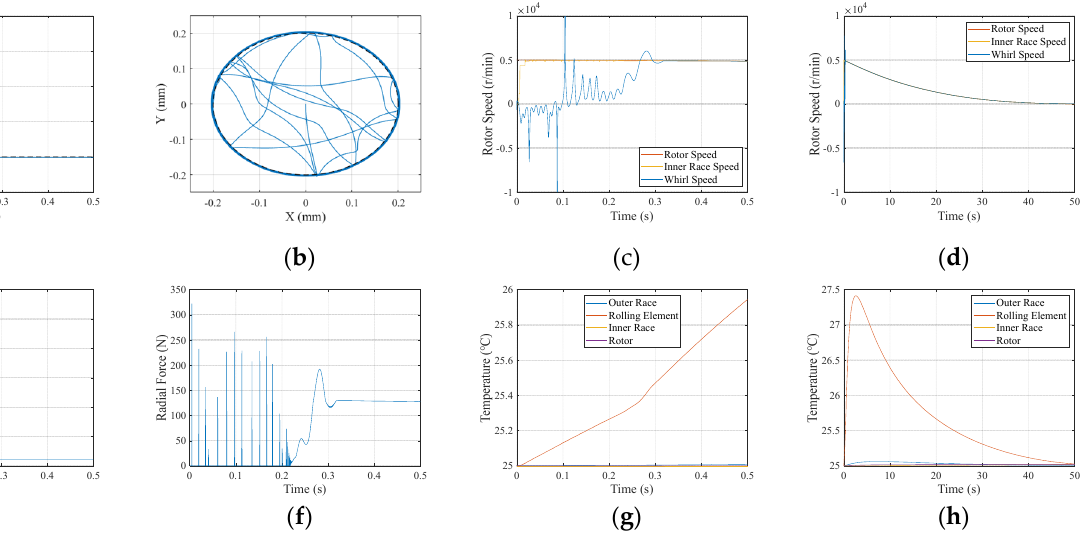
Figure 7. Numerical simulation results of the rotor touchdown at 5000 r/min: ( a ) Axial displacement, ( b ) Radial trajectory, ( c ) Rotor speed change in the first 0.5 s, ( d ) Rotor speed change for the whole process, ( e ) Axial contact force of the TDB, ( f ) Radial contact force of the TDB, ( g ) Temperature change in the first 0.5 s, ( h ) Temperature change for the whole process.